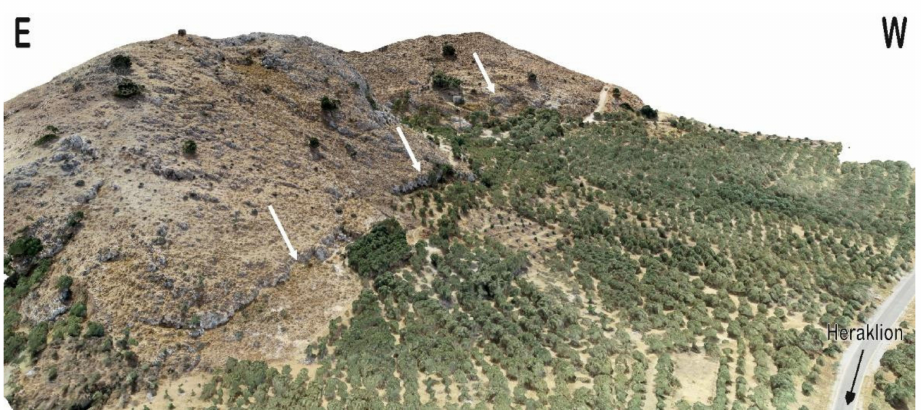
Figure 3. Photorealistic 3D model of a Kastelli fault segment, which, at some places, can be clearly identified by a morphological discontinuity (white arrows) or is quite difficult to distinguish where the morphology has been smoothened by the